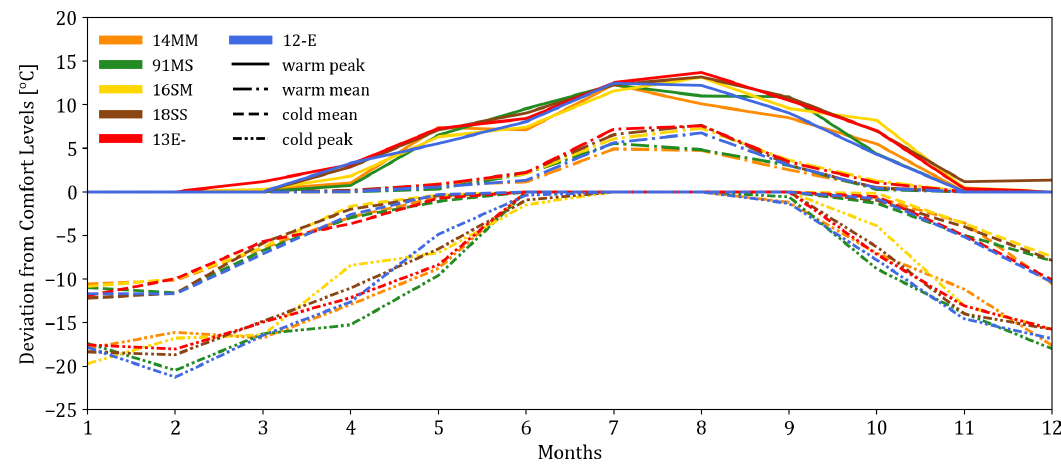
Figure 2. Temperature deviation of the representative year from the comfortable temperature of 18 °C to 22